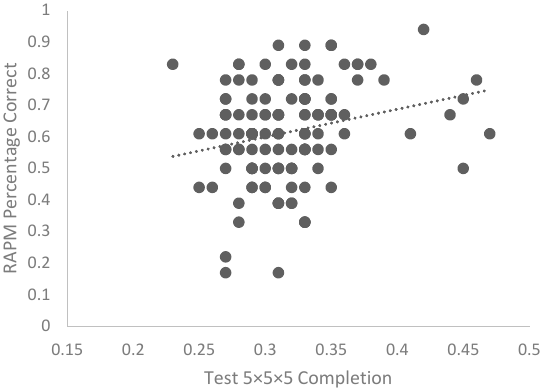
Figure 8. The 5 × 5 × 5 Rubik’s Cube Completion test and RAPM accuracy percentage across the full sample. 3.2. Exploratory Analyses In addition to the pre-registered analyses and the Bayesian analyses, we conducted two exploratory analyses. It could have been the case that variability in fluid reasoning was suppressing the effect of training order condition. To test whether 5 × 5 × 5 Rubik’s Cube completion depended on condition after controlling for fluid reasoning, we con- ducted with an ANCOVA where fluid reasoning served as the covariate. Condition did not emerge as a significant predictor after controlling for fluid reasoning F( 2,129) = 0.62, p = .540. A Bayesian ANCOVA verified this result, producing a Bayes factor of 7.409 in favor of the null hypothesis. We also tested whether fluid reasoning moderated the effectiveness of condition. Condition was dummy-coded with the consistent condition serving as the reference